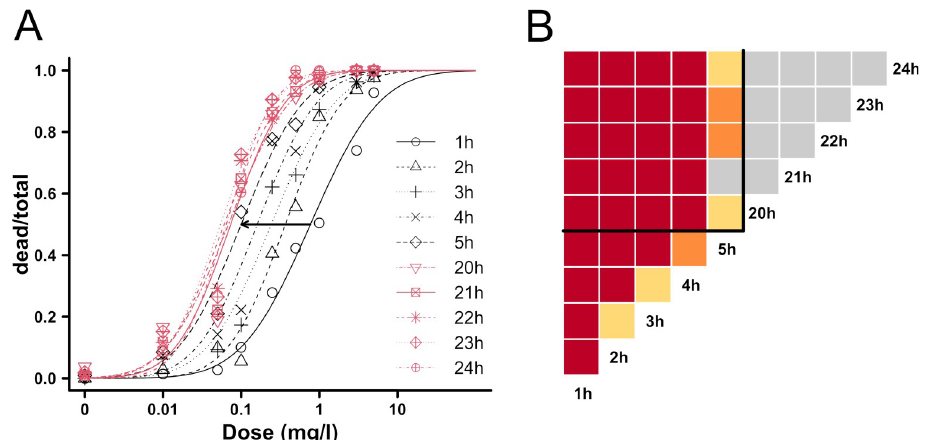
Fig 6. Effect of duration of exposure on LD 50 estimates in a D . suzukii population. The bioassay consisted of a tarsal exposure to lambda-cyhalothrin and was conducted on 24 to 48 hour-old D . suzukii adults from the Ste-Foy population. Panel A shows the change in the dose-response curves for female individuals. Early scoring (after 1, 2, 3, 4 and 5 h) curves are shown in black and late scoring (after 20, 21, 22, 23 and 24 h) curves are shown in red. The black arrow shows the variation in LD 50 between 1 and 5 h. The half-matrix in Panel B shows the significance levels of relative potencies between different exposure times for the female individuals (red: p < 0 . 001 ; orange: 0 . 001 � p < 0 . 01 ; yellow: 0 . 01 � p < 0 . 05 ; gray: ns